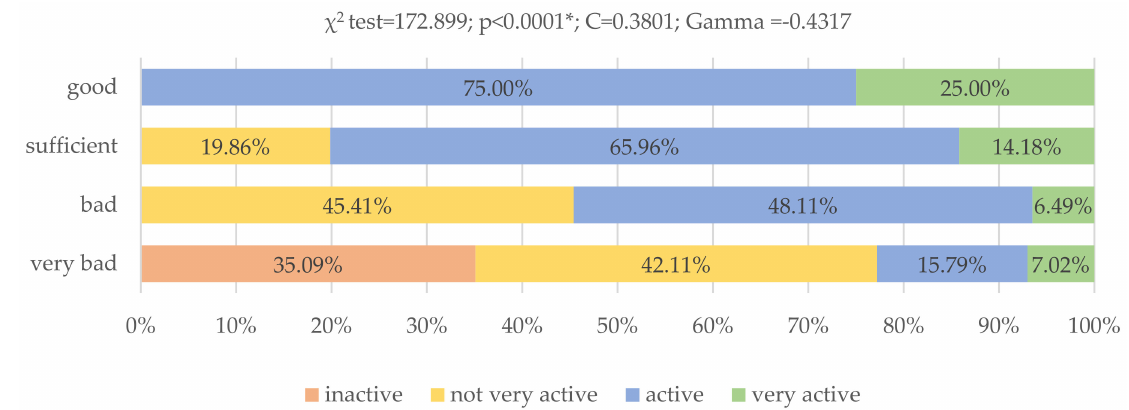
Figure 2. Assessment of nutritional behavior of young Poles and their physical activity ( N = 399). * Statistically significant differences ( p < 0.05). Source: own study based on the research.